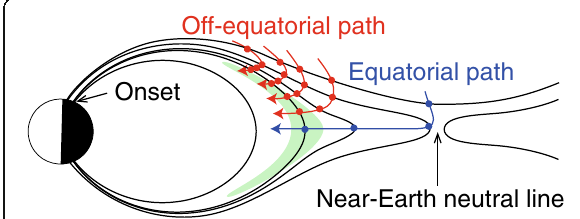
Fig. 11 A schematic of stream lines of plasma at expansion onset. The blue line indicates the stream line flowing near the equatorial plane. The red line indicates the stream line flowing at